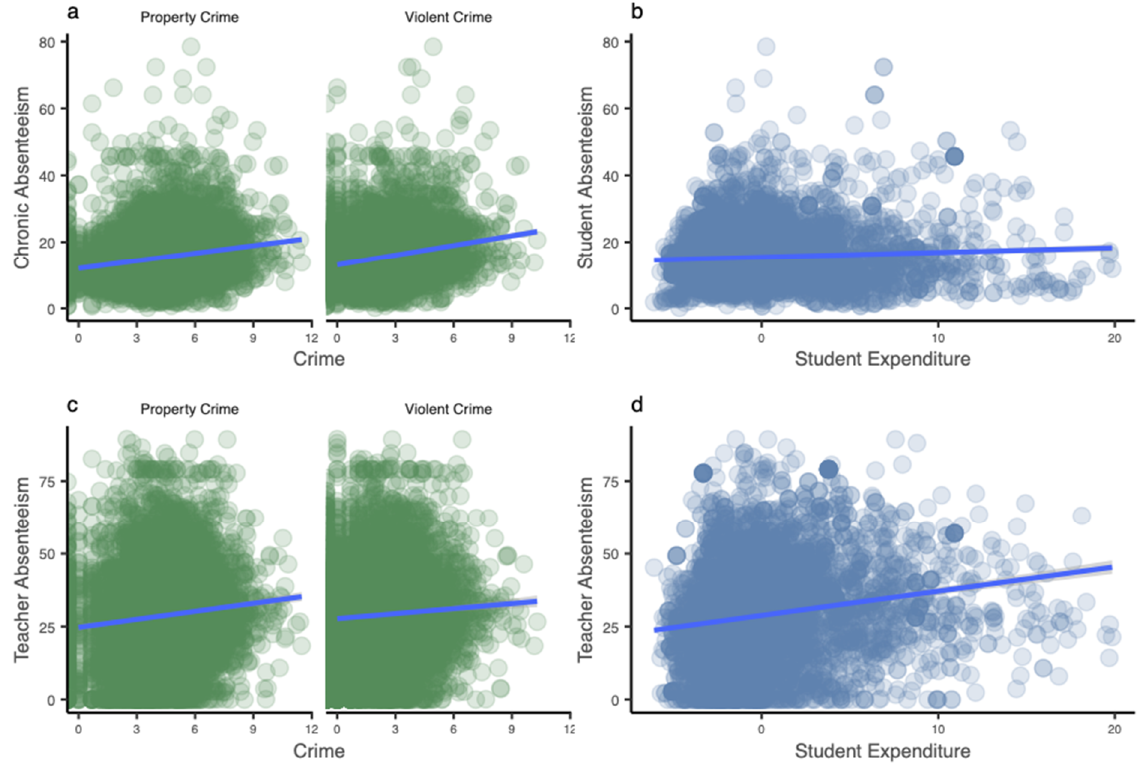
Figure 10. 2017 student chronic absenteeism and teacher absenteeism plotted by crime and student expenditure. While ( a ) reveals a positive cross-sectional correlation between chronic student absenteeism and crime, ( b ) demonstrates little correlation between student absenteeism and expenditure. ( c ) demonstrates positive correlation of teacher absenteeism with both property and violent crime and ( d ) shows an odd positive correlation in the increase of teacher absenteeism with student expenditure.